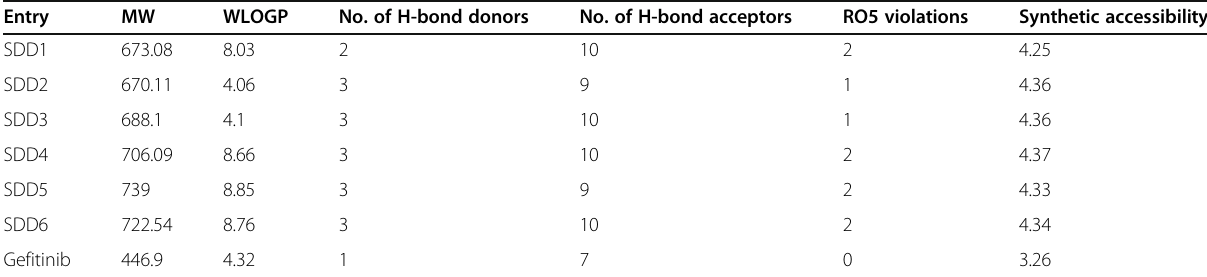
Table 5 Drug-likeness of newly designed EGFR